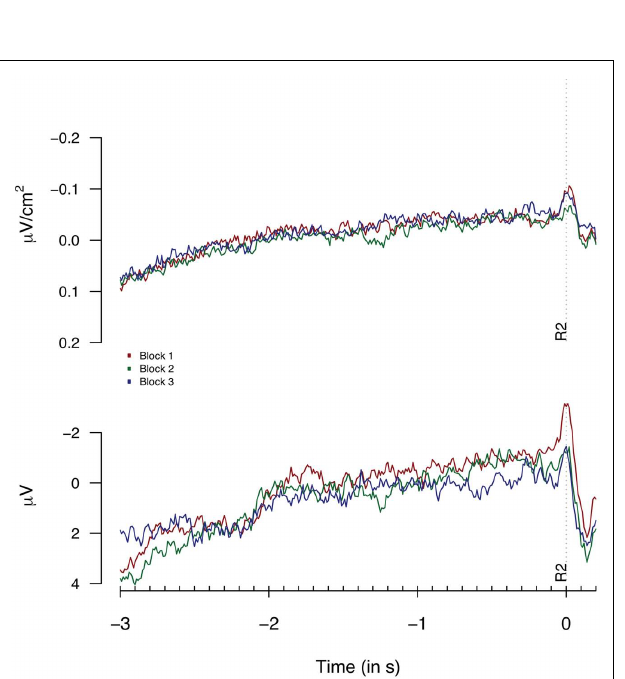
FIGURE 6 | Laplacians (top graph) and monopolar recordings (bottom graph) obtained at FCz during Experiment 2 as a function of participants’ behavioral performance, plotted time-locked to the second key press (R2). Laplacians are based on 8 “3-in-a-row” participants, monopolar data are based on all 15 participants.